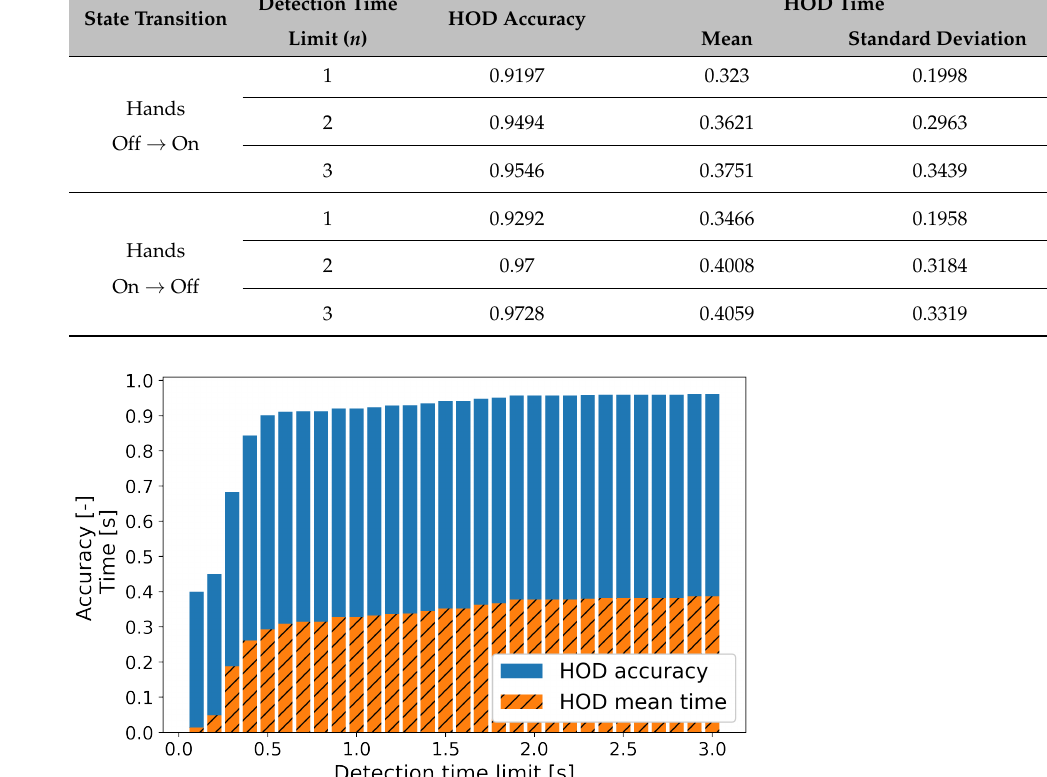
Figure 9. HOD accuracy and the mean HOD time according to the detection time limit on the test set. Figure 10 describes the detection time according to the time limit and state